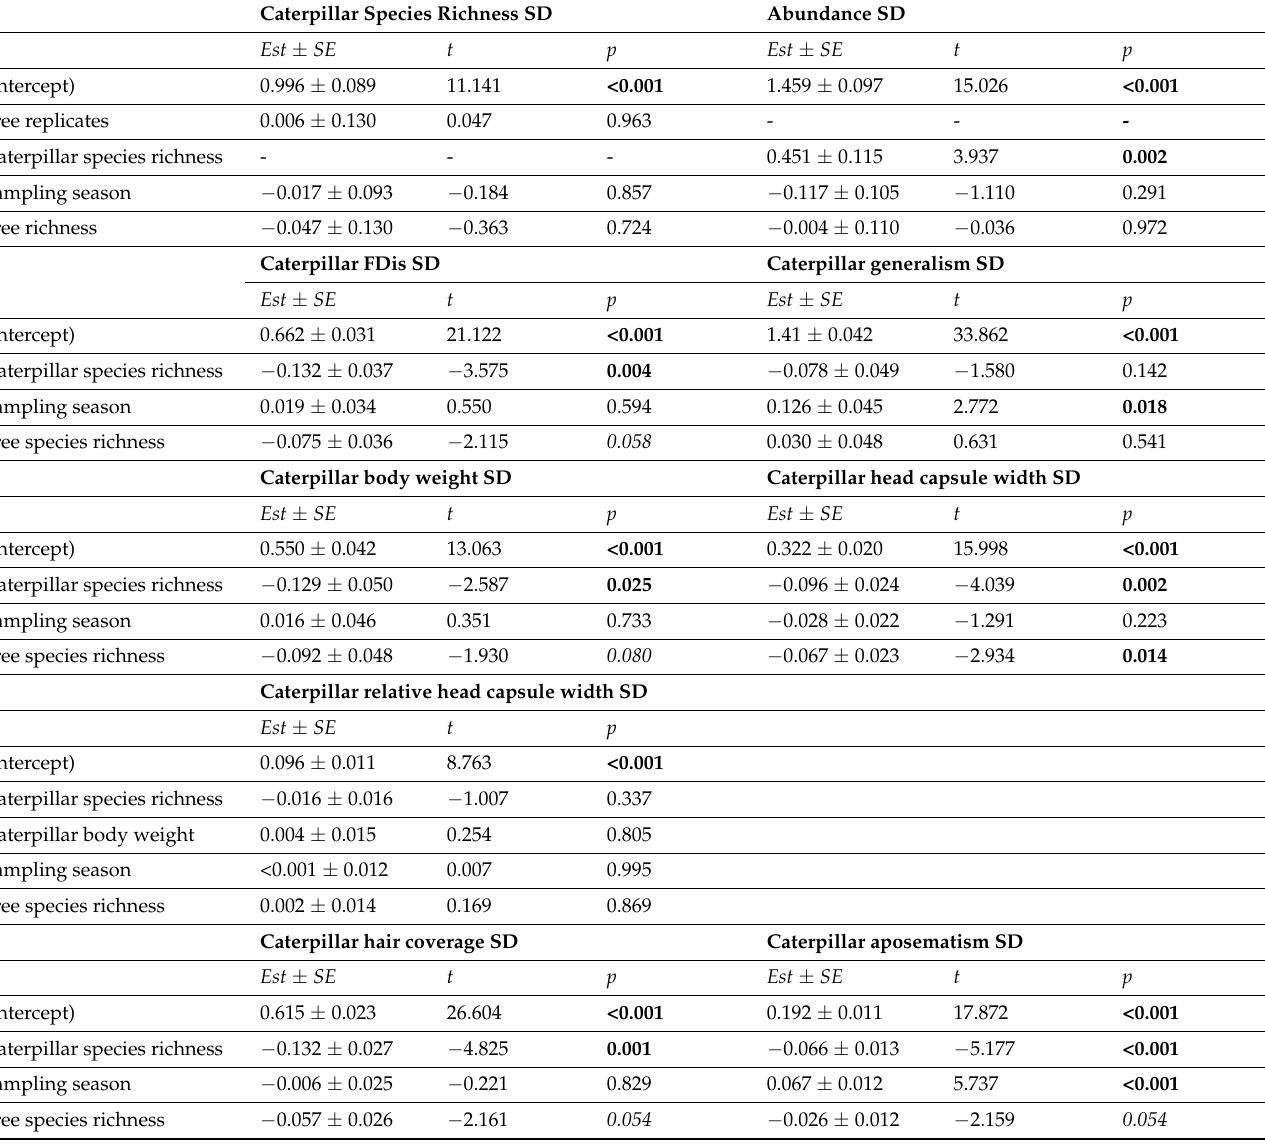
Table A1. Summary of linear model testing for changes in caterpillar trait standard deviations (SD) between tree species. All factors are scaled by subtracting the mean and dividing by standard devia- tion. All variables except tree replicates, sampling season, and tree richness are log + 1 transformed. Body weight values are also cube root transformed. Standardized parameter estimates (with standard errors, t, and p -values) are shown for explanatory variables. p -values in bold mean p ≤ 0.05, p -values of italic mean p ≤